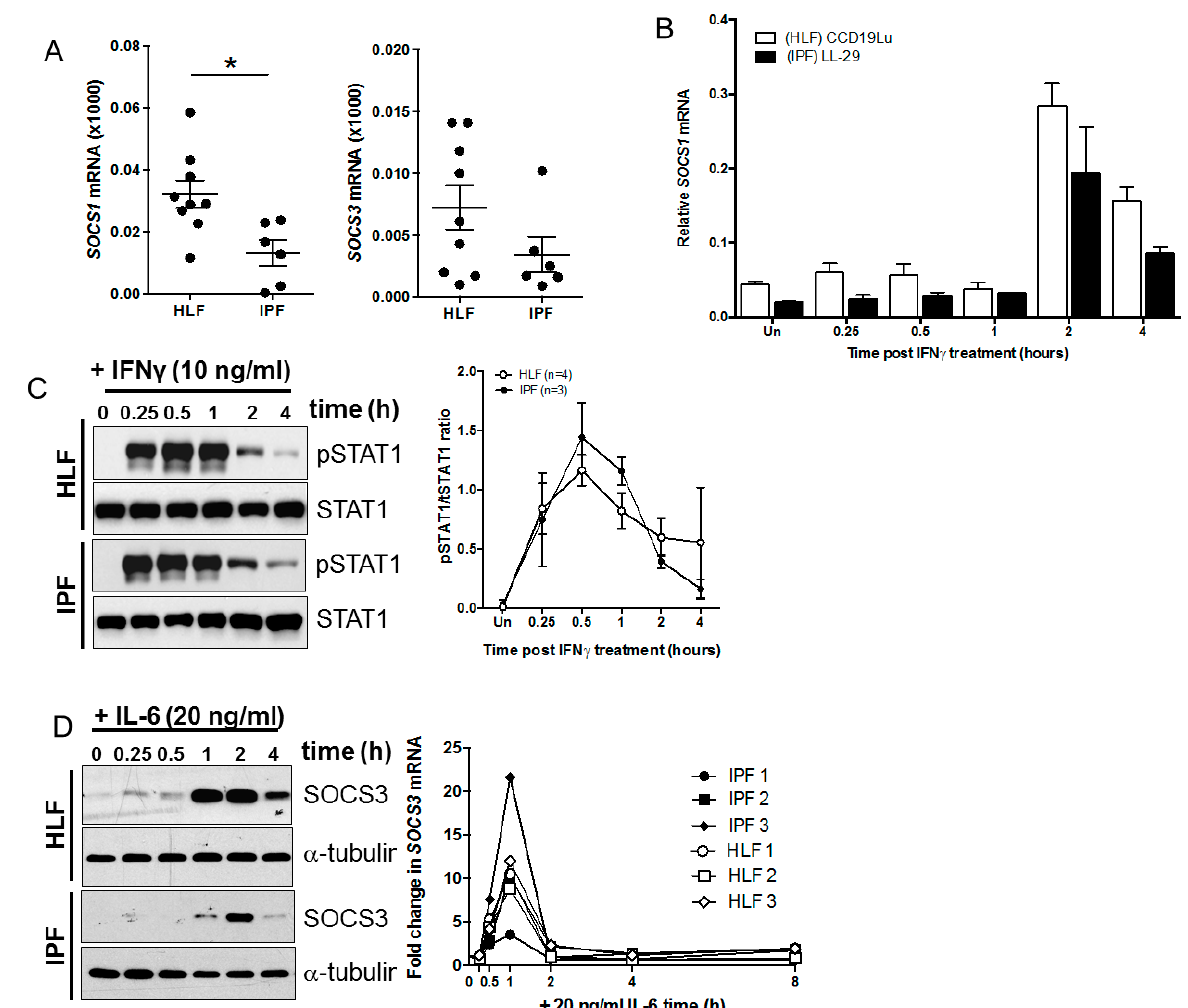
Figure 1. ( A ) SOCS1 is down regulated in IPF fibroblasts. SOCS1 and SOCS3 mRNA levels were determined in IPF ( n = 6) and control lung fibroblasts (HLF, n = 9) by qPCR and gene expression normalized to the housekeeping gene 18S. Data are represented as relative SOCS mRNA expression. SOCS1 levels were significantly reduced in IPF fibroblasts ( p = 0.0120). A trend towards reduced SOCS3 levels in IPF fibroblasts was also detected ( p = 0.1532). ( B ) The capacity for IFN γ to induce SOCS1 2 and 4 h following treatment with 10 ng/mL IFN γ was not altered. ( C ) Similarly, the kinetics of IFN γ -induced pSTAT1 and was not altered in in IPF fibroblasts (HLF n = 4, IPF n = 3 cell cultures for pSTAT1). ( D ) IL-6-induced SOCS3 mRNA and protein were not altered in IPF fibroblasts, although the magnitude of the response was varied (HLF and IPF n = 3 for SOCS3 mRNA